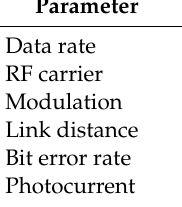
Figure 8. ( a ) Normalized co-polar directivity at H-plane at different frequencies for the two-row prototype adapted for probe measurements. Continuous line: simulation, dashed line: measurements. ( b ) Simulated and measured peak gain.